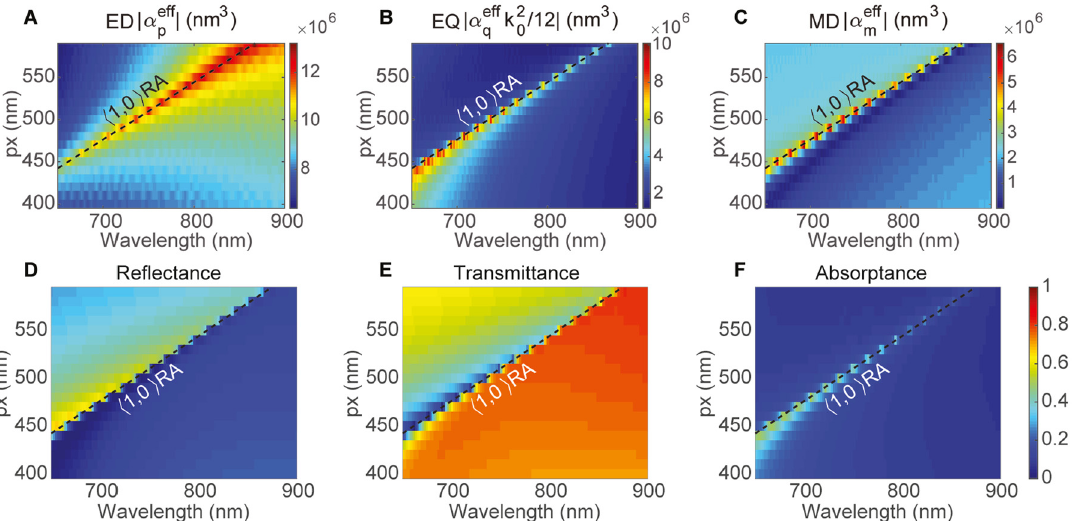
Figure 9: (Color online) Effective polarizabilities of (A) ED, (B) EQ, and (C) MD nanoparticle multipoles in the periodic array with fixed lattice periods p y =250nmandvariant p x .(D)Re fl ection,(E)transmission,and(F)absorptionlinearspectrainperiodicarraywith fi xedlatticeperiods p y = 250 nm and variant p x . The dashed lines show the 〈 1 , 0 〉 Rayleigh anomaly wavelength for each lattice spacing.